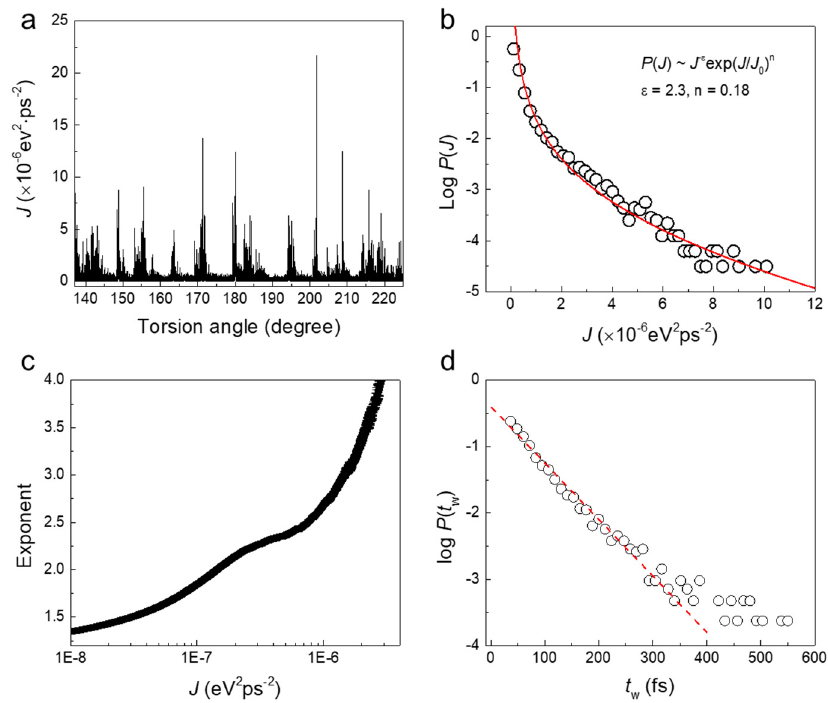
Figure 7. Statistical analysis of jerk strength for a twisted nanowire in the regime B. ( a ) Jerk spectrum at 137° < θ < 225°. ( b ) Semi-log plot of the PDF of jerk strengths showing a generalized Poisson distribution. The stretching exponent is n = 0.18. ( c ) Evaluated exponent by the ML method, where there is a small plateau at ε = ~2.3. The ML curve shows highly damped dynamics. ( d ) Exponential distribution of waiting times between successive jerks.